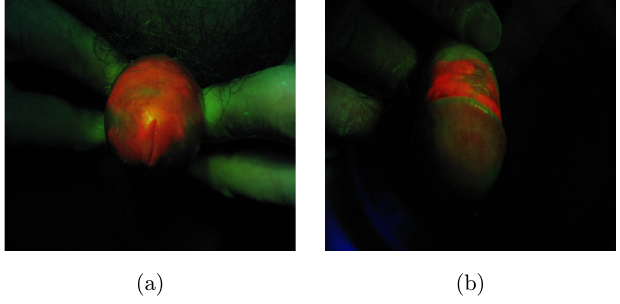
Fig. 2. PpIX °uorescence images after topical application of ALA. (a) case 6 and (b) case